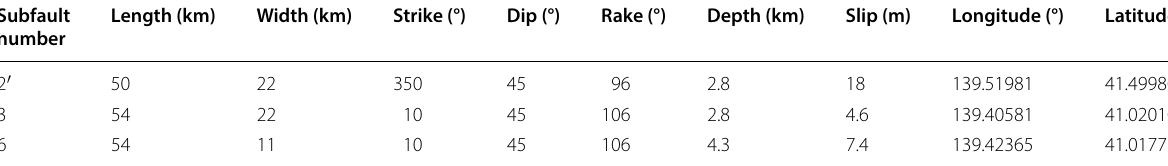
Table 2 Subfault model parameters of modified fault model F17 in this study Subfault number